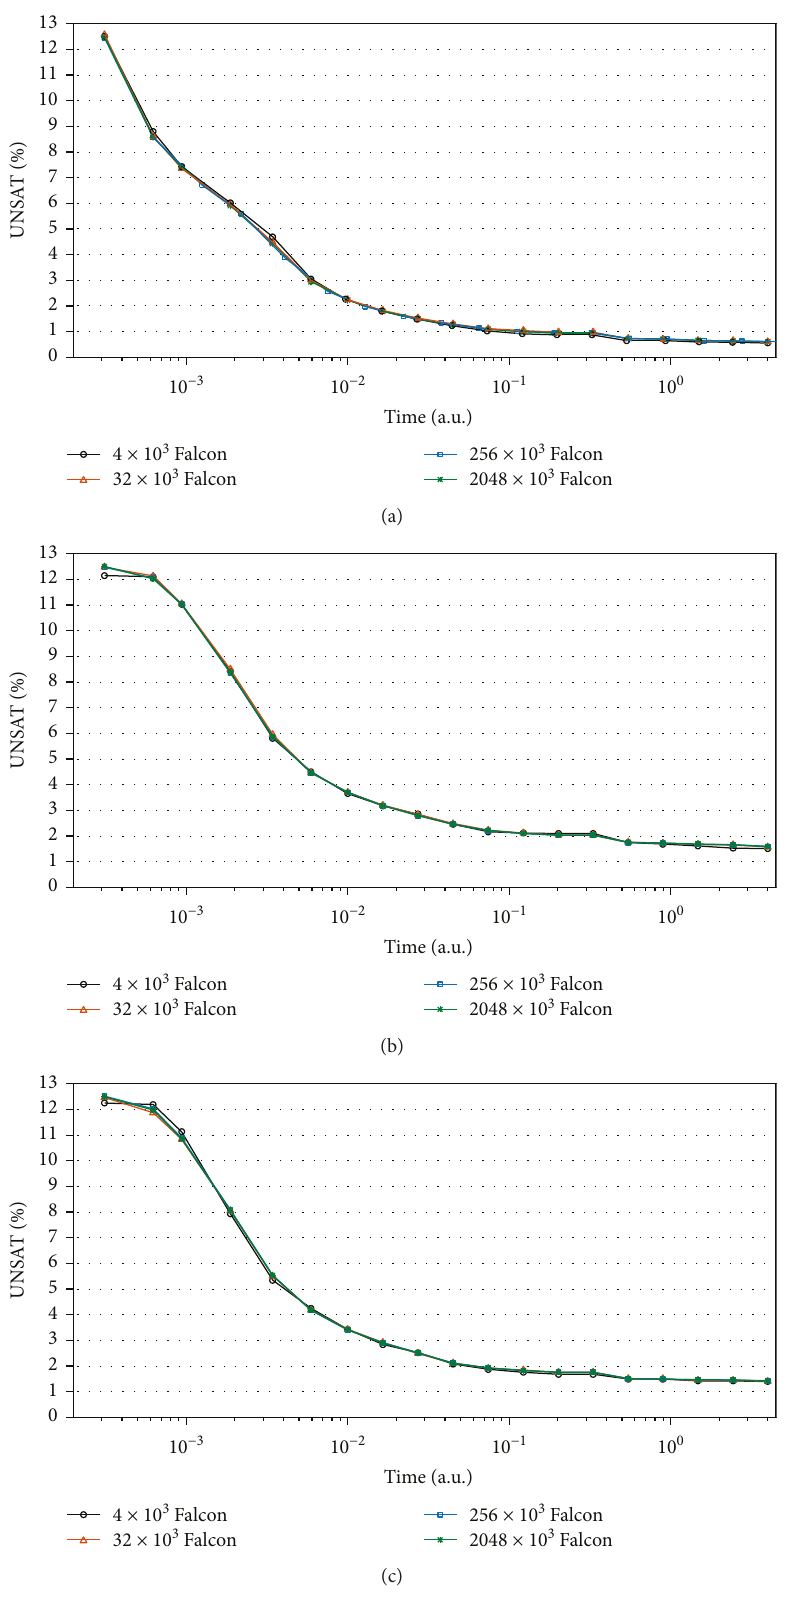
Figure 5: Percentage of unsatis fi ed clauses versus the machine time (i.e., simulated time steps) is shown to highlight the linear scaling of our solver, Falcon, for (a) random-Max-E3SAT, (b) hyper-Max-E3SAT, and (c) delta-Max-E3SAT. All calculations have been performed on a single thread of an Intel Xeon E5-2680 v3 with 128 Gb DRAM shared on 24